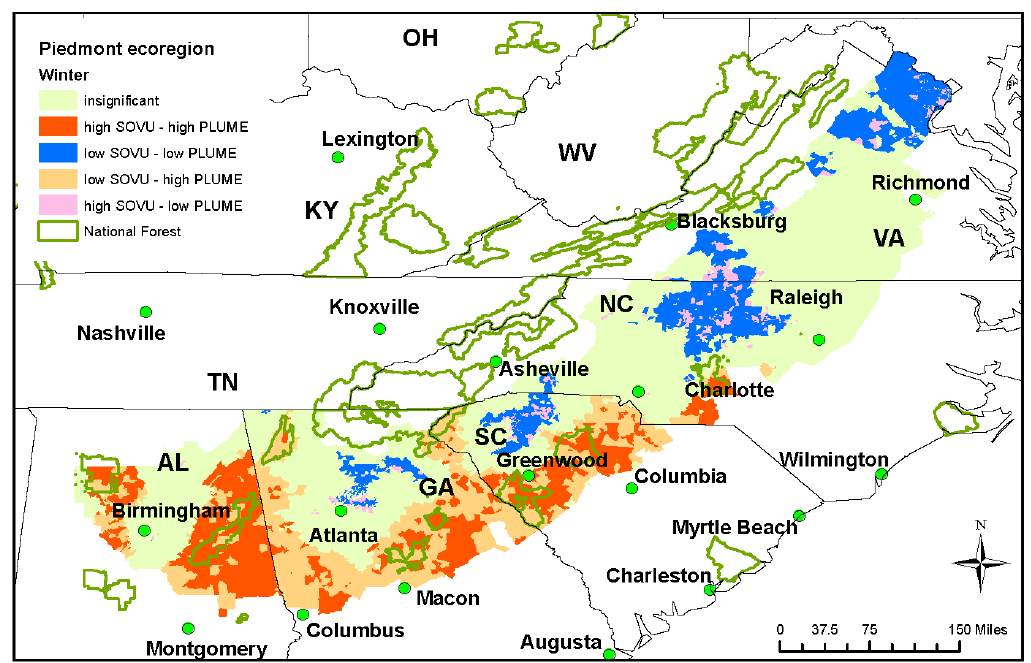
Figure 6. Bivariate LISA mapping of social vulnerability and smoke plume in the Piedmont ecoregion—winter.